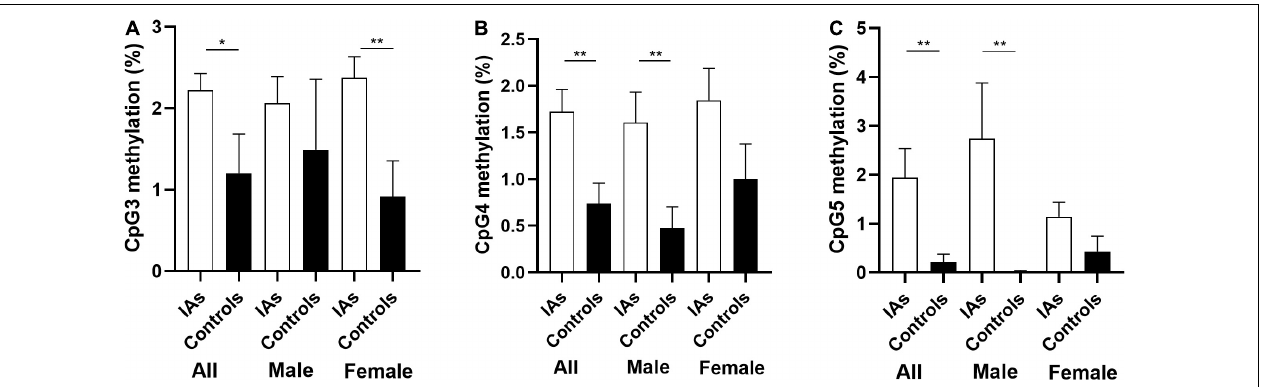
FIGURE 2 | Comparison of PTBP1 promoter CpG3, CpG4, CpG5 methylation between IAs and controls in different sex. (A) The comparison of CpG3 methylation among groups. (B) The comparison of CpG4 methylation among groups. (C) The comparison of CpG5 methylation among groups. * p < 0.05, ** p < 0.001.